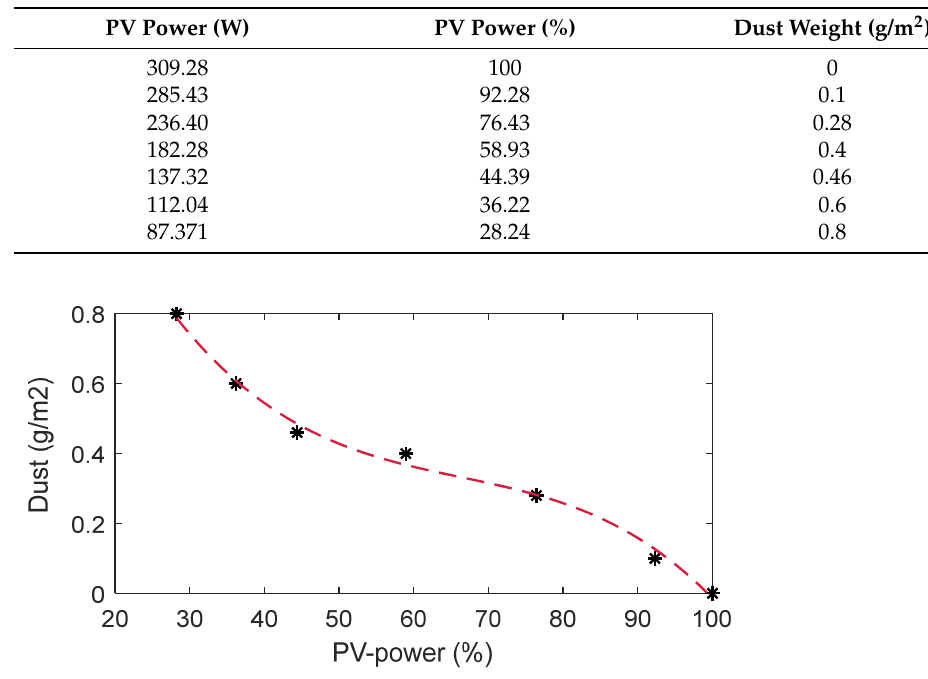
Figure 6. Percentage of normalized PV output power versus dust weight: (starred black) collected data, (dotted red) fitting curve.